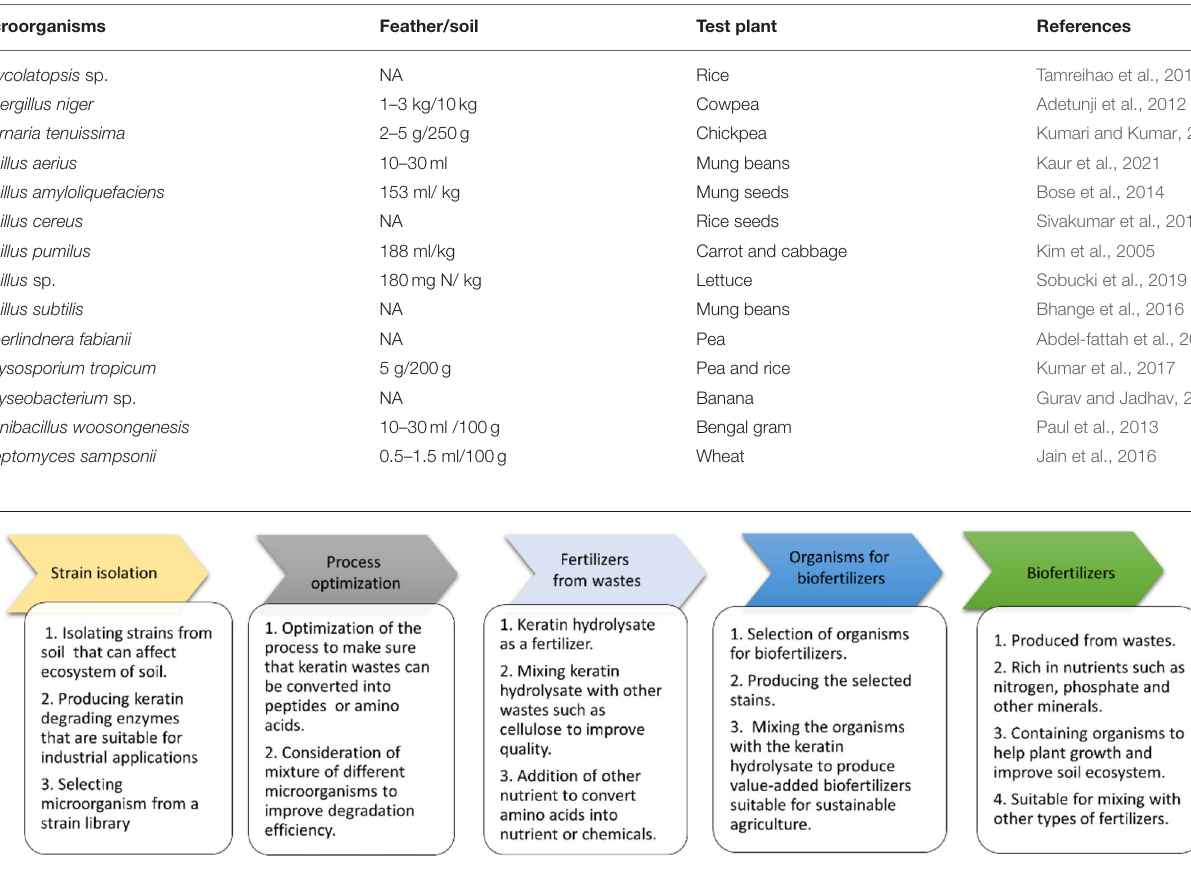
FIGURE 5 | A strategy to convert keratin-containing waste into